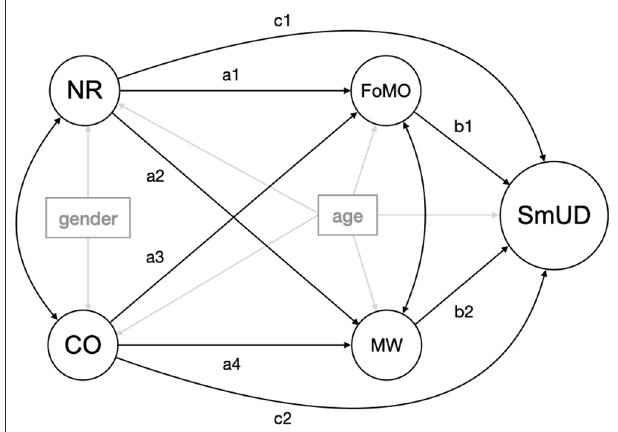
FIGURE 1 | Graphical representation of the theoretical research model. It shows the assembly of the latent constructs, depicted as circles (NR, CO, FoMO, MW, SmUD) and measured covariates (age, gender) displayed as rectangles (manifest variables). For reasons of clarity, items of latent variables are not presented here, however, they were used in calculating the model. Paths illustrated with one arrow tip signify a regression effect on the construct they point at, and two arrow tips indicate a covariance between two constructs. CO, Conscientiousness; NR, Neuroticism; MW, Mind-Wandering; FoMO, Fear of Missing Out; SmUD, Smartphone Use Disorder. We also note that the covariates age/gender have often been associated with several of the investigated variables (for reasons of brevity not discussed in this work) and, therefore, need to be controlled